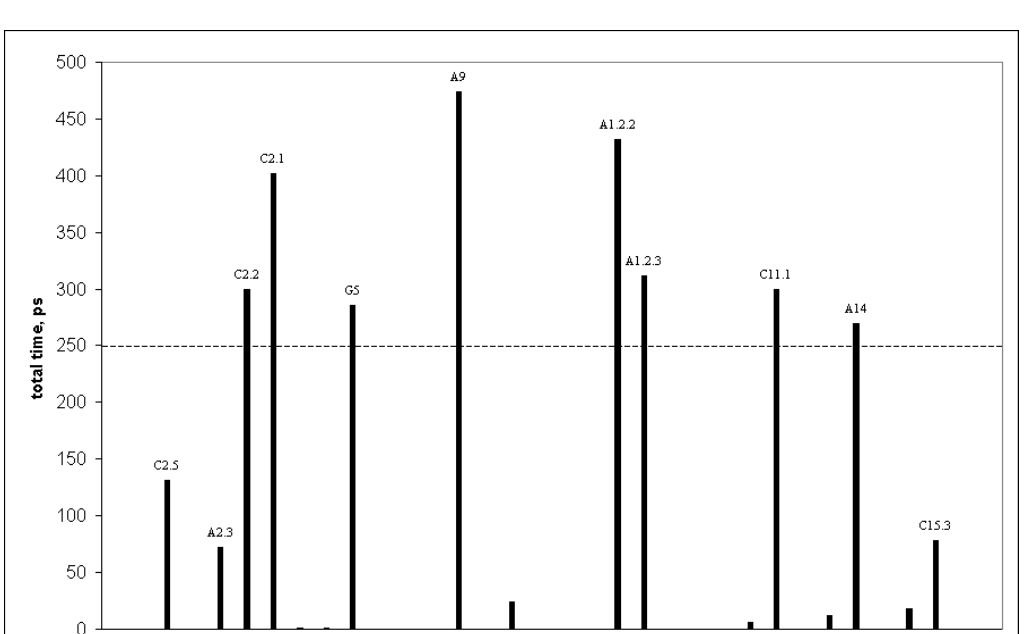
FIGURE 4 . Results of molecular dynamics of a hammerhead ribozyme represented as an “occupancy profile”. The least stabilizing nucleotides were selected using 2E max as cut off at each snapshot (1 ps). Total trajectory was 500